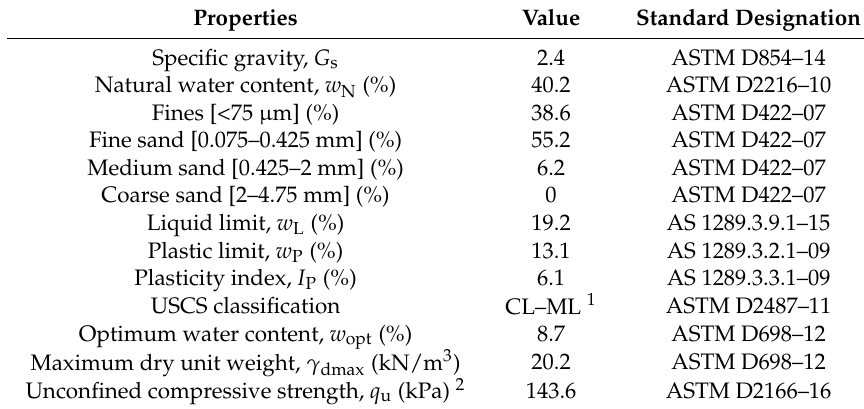
Table 1. Physical and mechanical properties of the used tailings.